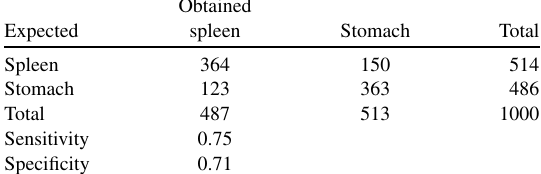
The results of the classification of the individual nuclei by the neural network.Onlythenucleinotusedfornetworktrainingwereincluded